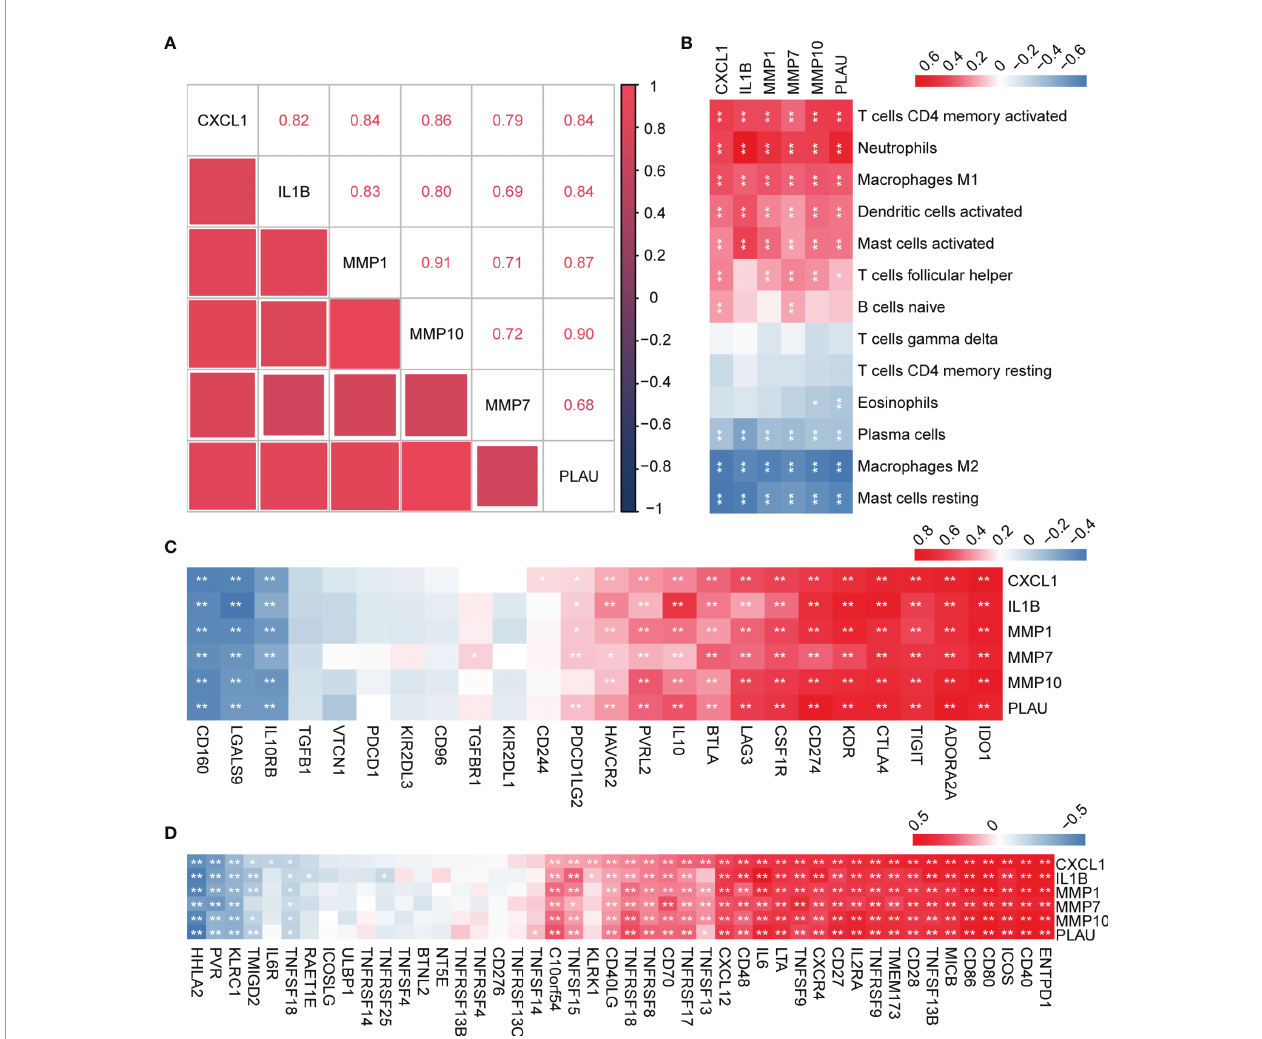
FIGURE 7 | Correlation analysis between hub genes with immune cell types and factors. (A) Correlation analysis of the six hub genes. (B) Correlation analysis of hub genes and different immune cell types. (C, D) Correlation analysis of hub genes with immunosuppressive and immunostimulatory factors. * P < 0.05, ** P <